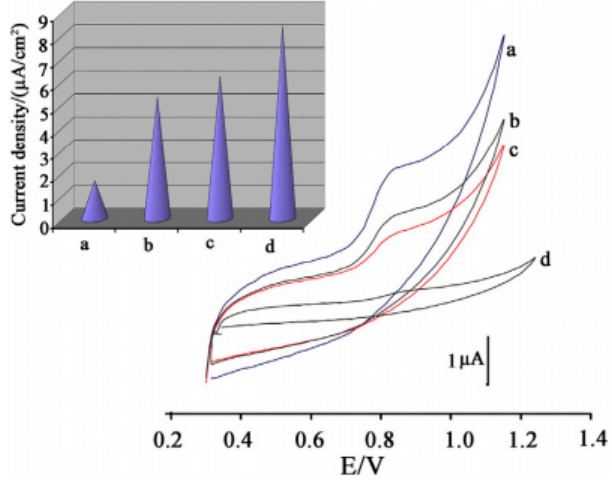
Figure 9. CV of (a) CPE/RuO2/NR/DPIBr; (b) CPE/DPIBr; (c) CPE/DPIBr; and (d) CPE in the buffer solution at pH = 7.0 in the presence of 200 µ M Amaranth. Inset: the current density derived from cyclic voltammogram responses of 200 µ M AM at pH 7.0 at the surface of different electrodes. Reprinted with the permission of Reference [35]. [License Number 5067500461346]. Table 5. Table showing Amaranth detection using carbon paste electrodes with different modifiers along with their detection limits.